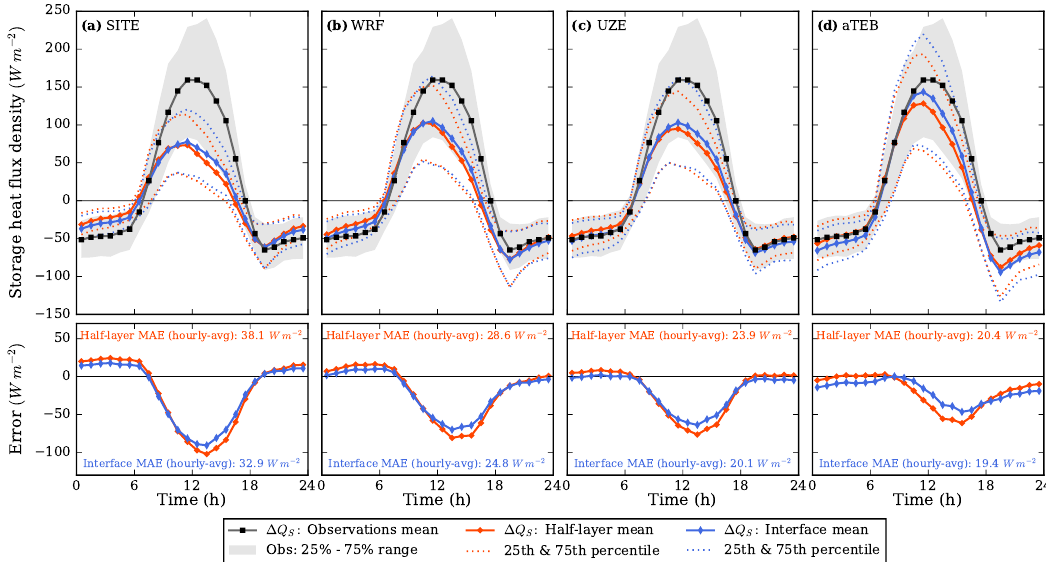
Figure 6. Hourly averaged diurnal heat storage response of an urban land surface model to four wall/roof datasets over 12 months. Material datasets per Fig. 4 and Appendix A. In each case, the interface scheme reduces errors by increasing heat storage amplitude. Only Harman aerodynamic heat transfer parameterisation shown (others qualitatively similar). When evaluation is limited to 3-month seasons, differences between schemes are qualitatively similar to annual results, although overall errors are higher in summer where radiation flux magnitudes are larger (not shown). The MAE for hourly averaged fluxes of a mean day shown here is different to MAE of each half-hour time step throughout the evaluation period (Table